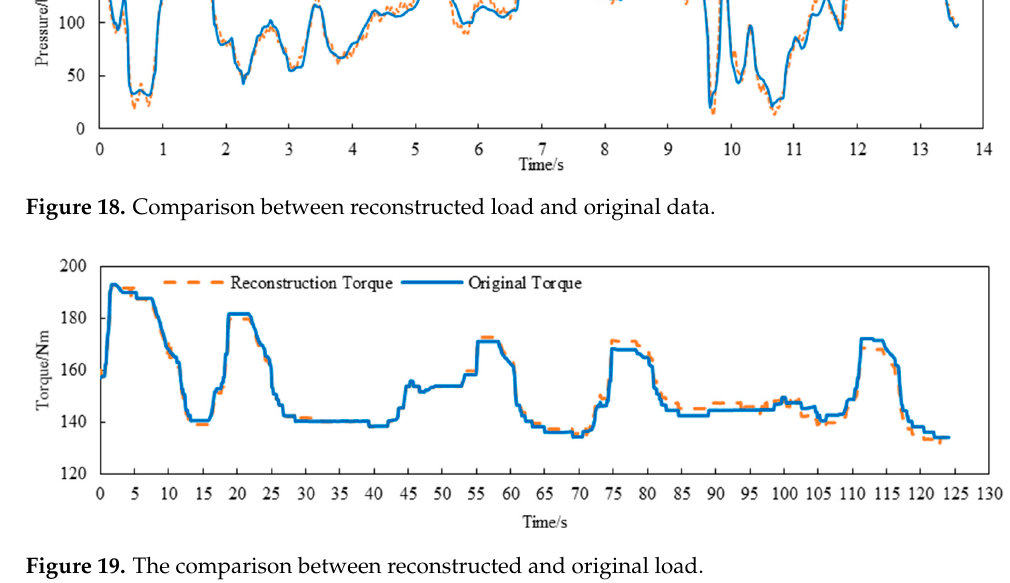
Figure 19. The comparison between reconstructed and original load.